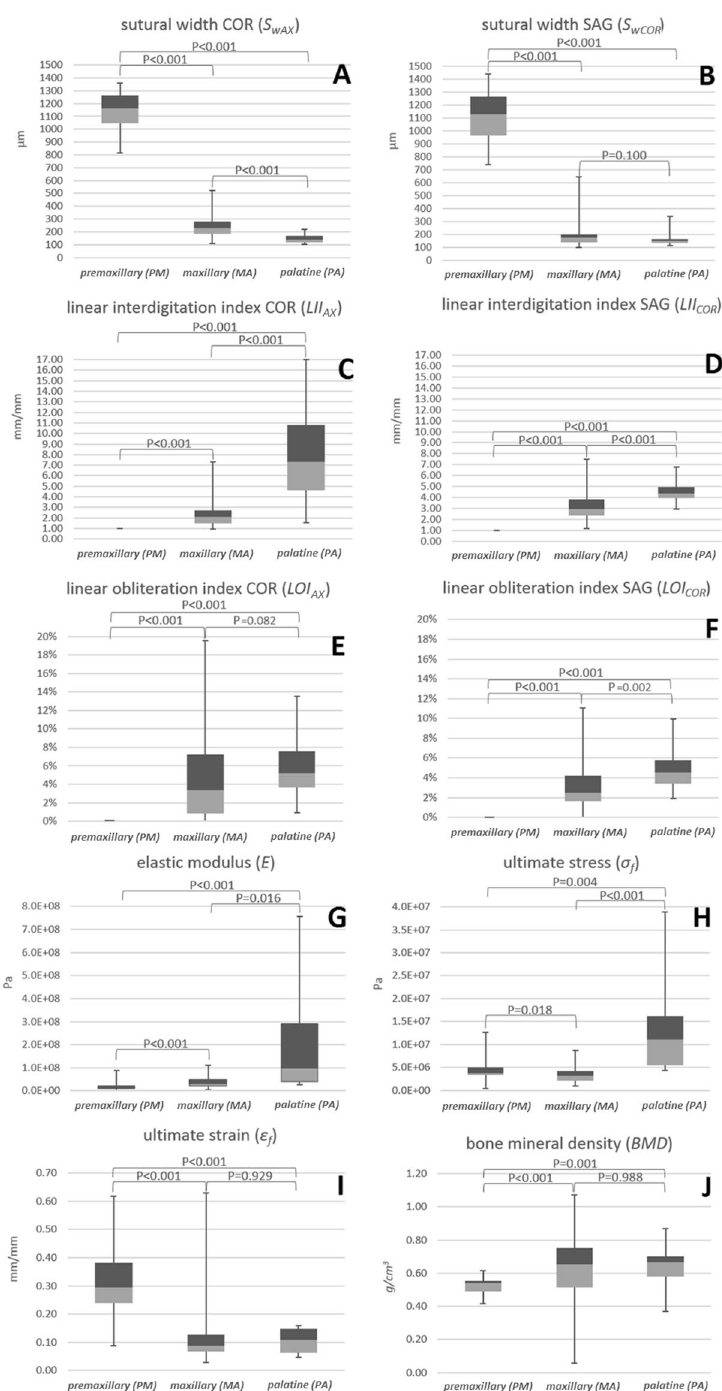
Figure 4. Sutural width ( Sw ) ( A and B ), linear interdigitation index ( LII ) ( C and D ), and linear obliteration index ( LOI ) ( E and F ) values in the axial (AX) and coronal (COR) plane. Elastic modulus ( E ) ( G ), failure stress ( σ f ) ( H ), failure strain ( ε f ) ( I ), bone mineral density ( BMD ) ( J ) values in the three analysed regions. Boxplot parameters: the top line of the upper box (dark grey) represents the 75 th percentile (3 rd quartile); the line between the upper box and the lower box represents the 50 th percentile (2 nd quartile); the bottom line of the lower box (light grey) represents the 25 th percentile (1 st quartile); the top of the upper whisker represents the maximum and the bottom of the lower whisker represents the